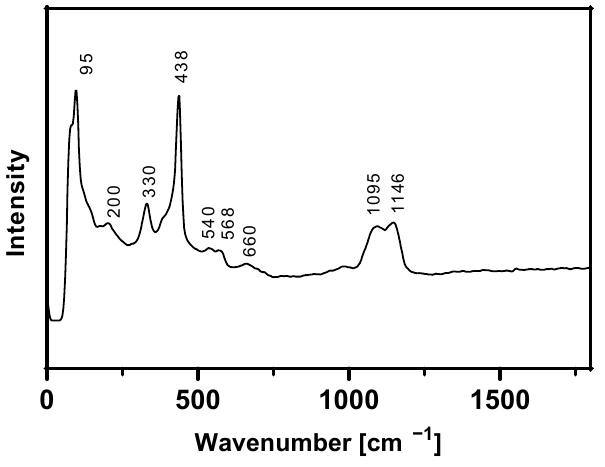
Figure 1. Raman spectrum of the ZnO NPs.